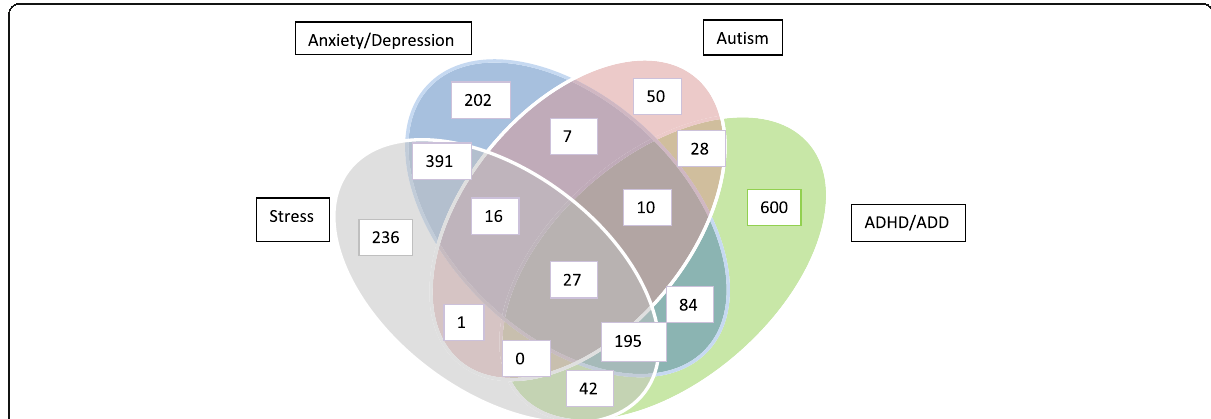
Fig. 2 Combinations of mental health conditions for the 1889 children responders in the NHIS CAL supplementary questionnaire with at least one mental health